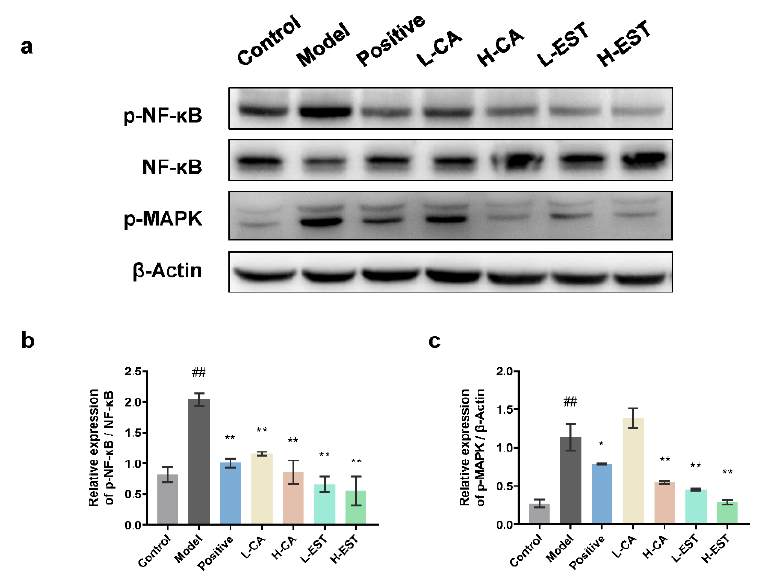
Figure 6. Effects of EST and CA on liver p-NF- κ B, NF- κ B, p-MAPK expression. ( a ) Western blotting analysis of p-NF- κ B, NF- κ B, and p-MAPK expression in liver tissues and densitometric quantification of p-NF- κ B/NF- κ B ( b ) ( n = 3). ( c ) Western blotting analysis of p-MAPK expression in liver tissues and densitometric quantification of p-MAPK ( n = 3). Data are expressed as mean ± SD.